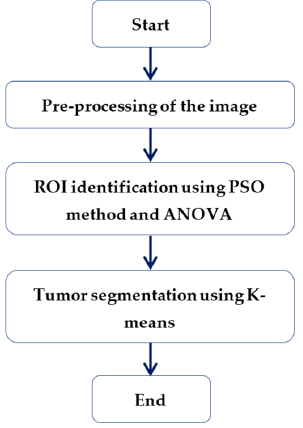
Figure 7. Diagram of the proposed approach.